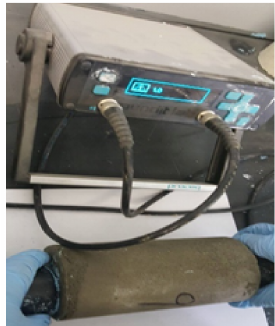
Figure 7. Ultrasound pulse velocity test setup.